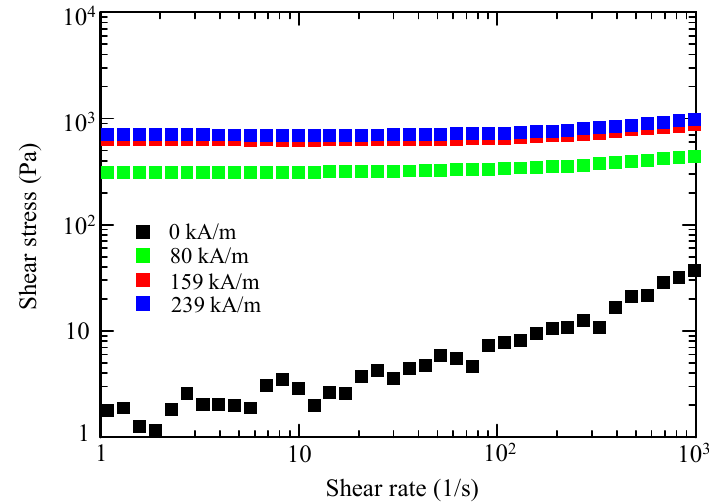
Figure 5. Flow curves under the magnetic fields for a Fe 3 O 4 suspension (10 vol. %) containing spherical particles.